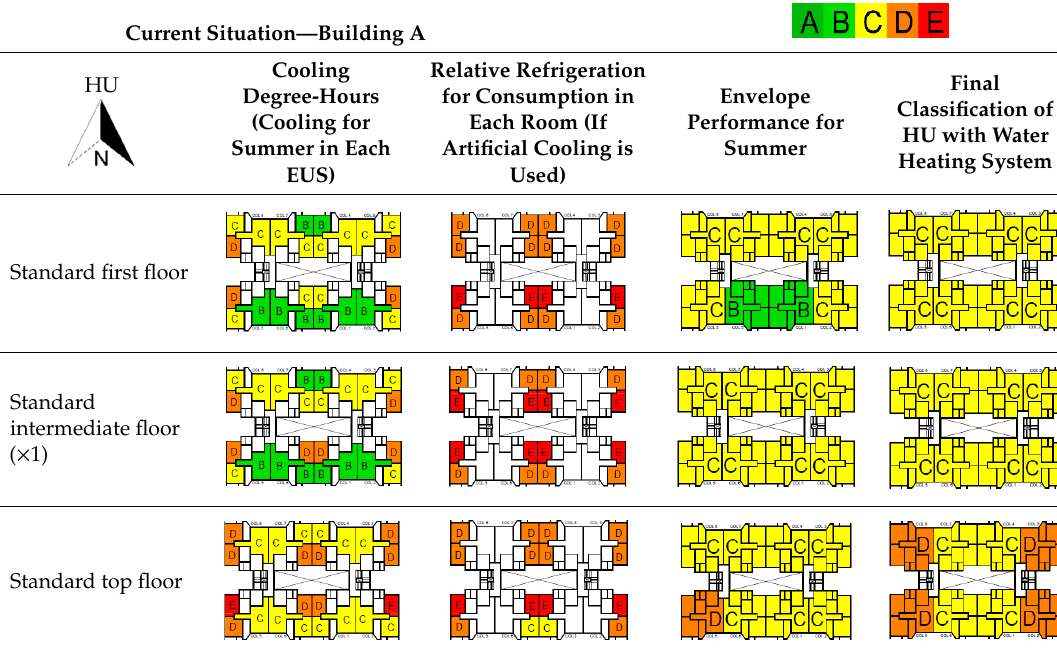
Table 5. Graphical representation of the standard floor of Representative Building A with the Table 6. Graphical representation of the standard floor of Representative Building B with the classification based on energy e ffi ciency assessment. classification based on energy efficiency assessment.